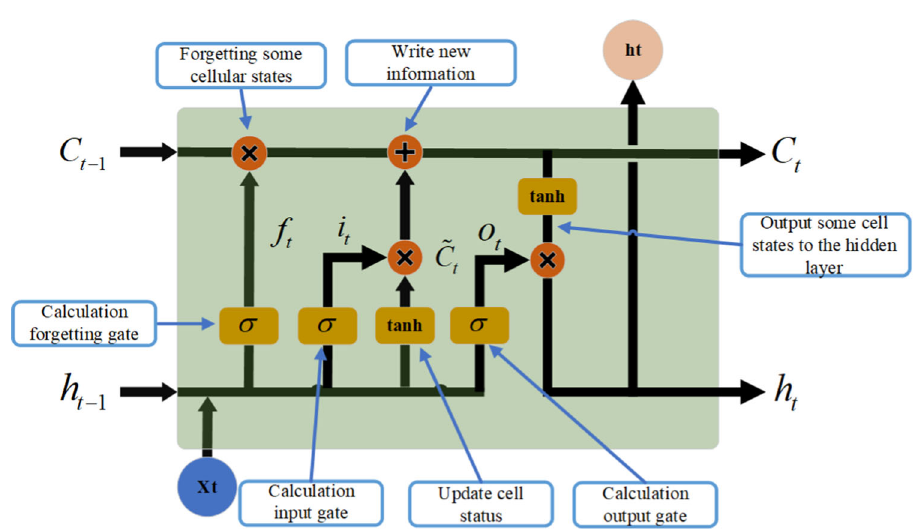
Fig. 6 The network structure of LSTM at time t